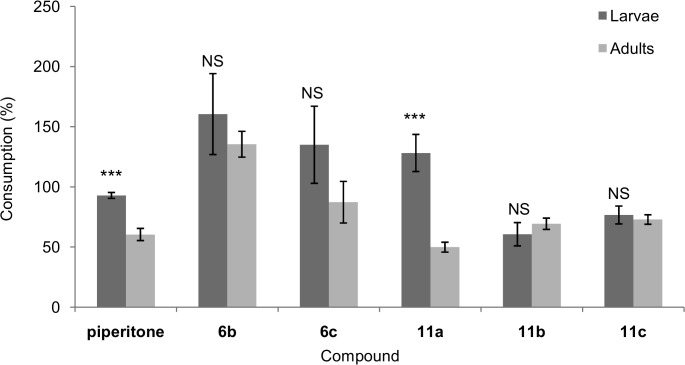
Effects of piperitone and hydroxy lactones (6b,c and 11a-c) on the feeding of Leptinotarsa decemlineata larvae and adults in no-choice tests.Data are expressed as percentages of control consumption. Values represent the means of four replicates, each set by using ten larvae or adults (n = 40). The standard error is indicated on each bar. *** p < 0.001; NS: not significant (Student’s t-test).